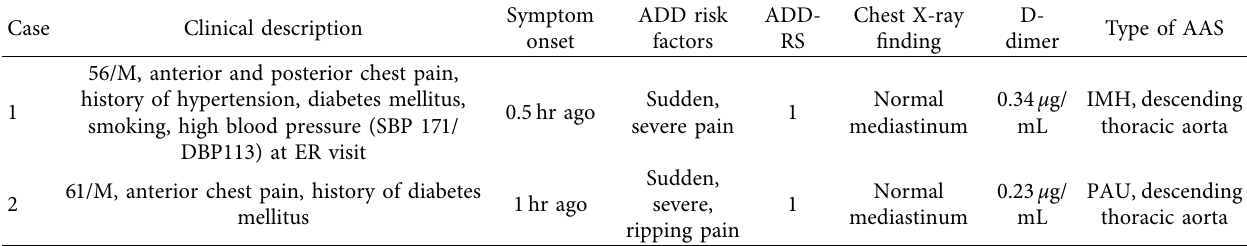
Table 4: Clinical presentation of two cases of false negative results obtained with the D-dimer